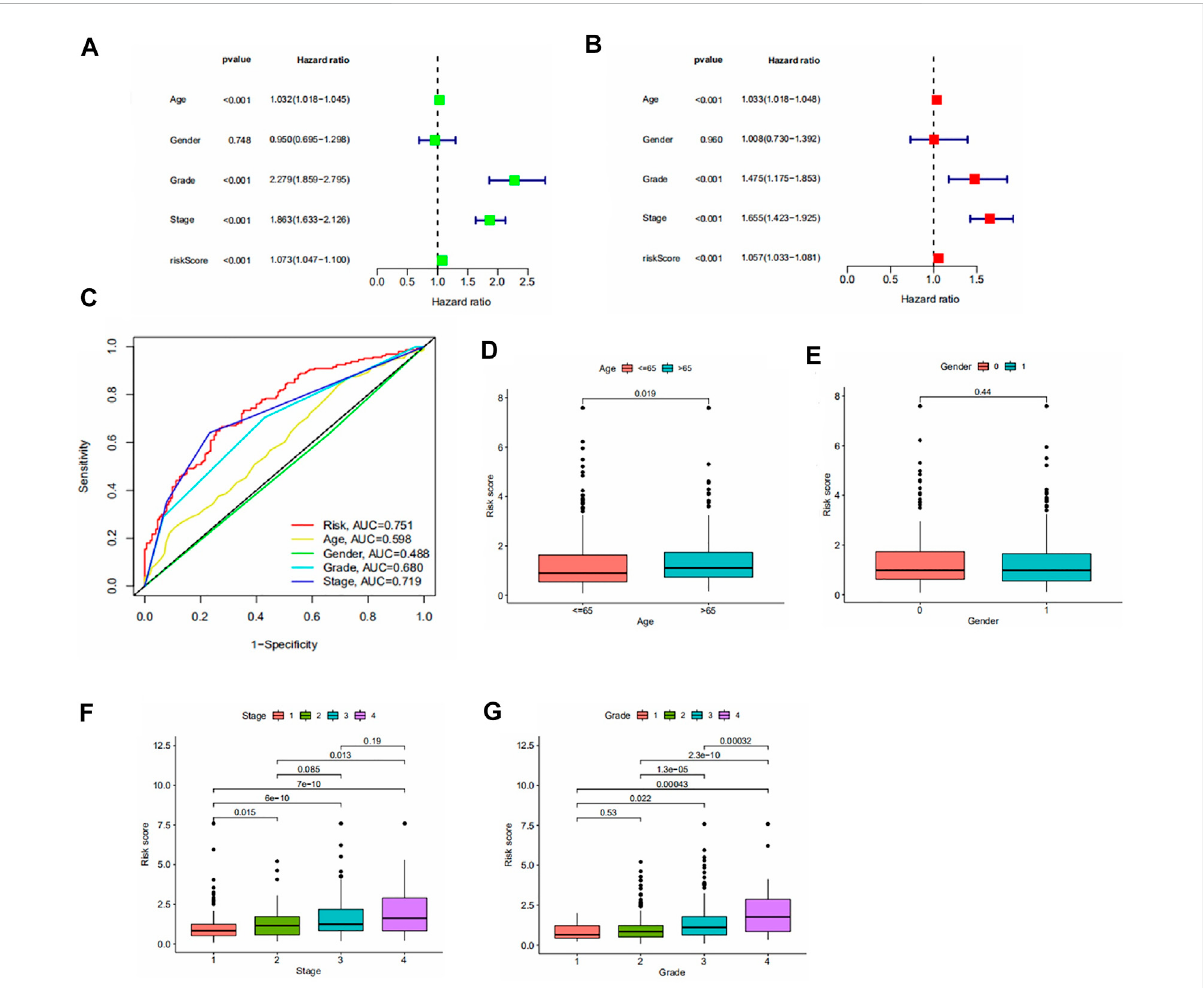
FIGURE 3 (A,B) Forest plot of univariate/multivariate independent prognostic analysis ( p < 0.05 is statistically signi fi cant, the larger the hazard ratio, the higher the correlation). (C) Area under the roc curve for risk scores and clinical information. (D – G) Results of the clinical correlation analysis. Differences in risk scores by age, gender, stage, and